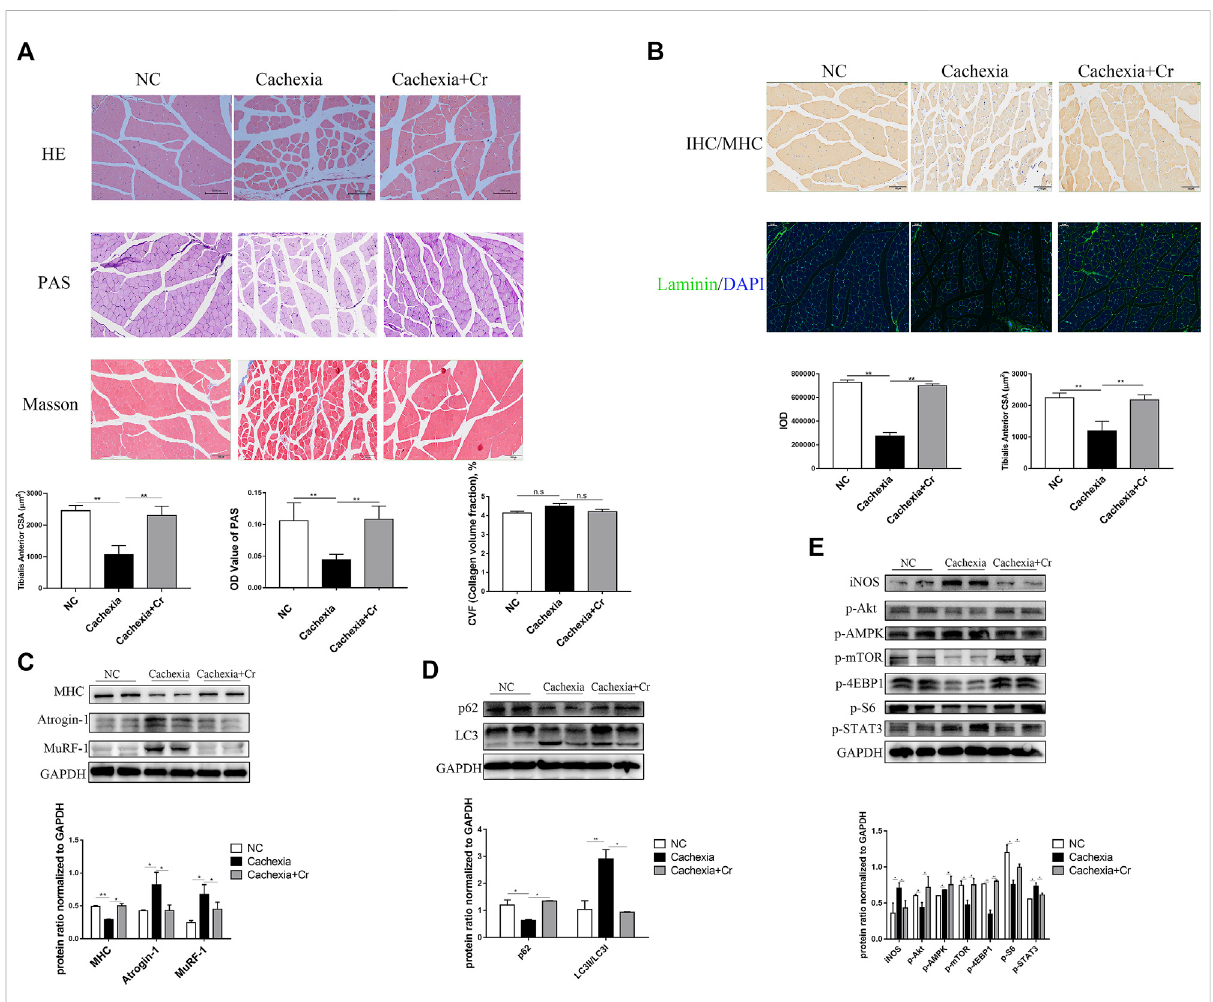
FIGURE 2 Supplementation with creatine inhibits UPS and ALS activation, thereby preventing skeletal muscle atrophy. (A) Representative HE staining showing the morphological changes inthe muscles of the three groups. Average size ofmuscle fi ber cross-sectionalarea in the NCmice, cachectic mice, or creatine-treated cachectic mice. Representative Masson ’ s trichrome staining of paraf fi n sections from muscle fi bers of different groups of mice is shown. The bar graph shows the collagen volume fraction (CVF) measured by ImageJ. The glycogen content was determined by Periodic Acid-Schiff (PAS) staining. The histogram shows the optical density (OD) of PAS staining. (B) Gastrocnemius myosin heavy chain (MHC) expression was evaluated by immuno fl uorescence (IF) staining. The bar graph shows the mean gray value of different groups. Gastrocnemius sections were stained with an antibody against laminin and DAPI. The bar graph shows the mean gray value of different groups. (C) Western blot analysis was used to evaluate MHC, Atrogin-1 and MuRF-1 expression in the three groups (mean ± SD, n = 6). * p < 0.05, ** p < 0.01. (D). Western